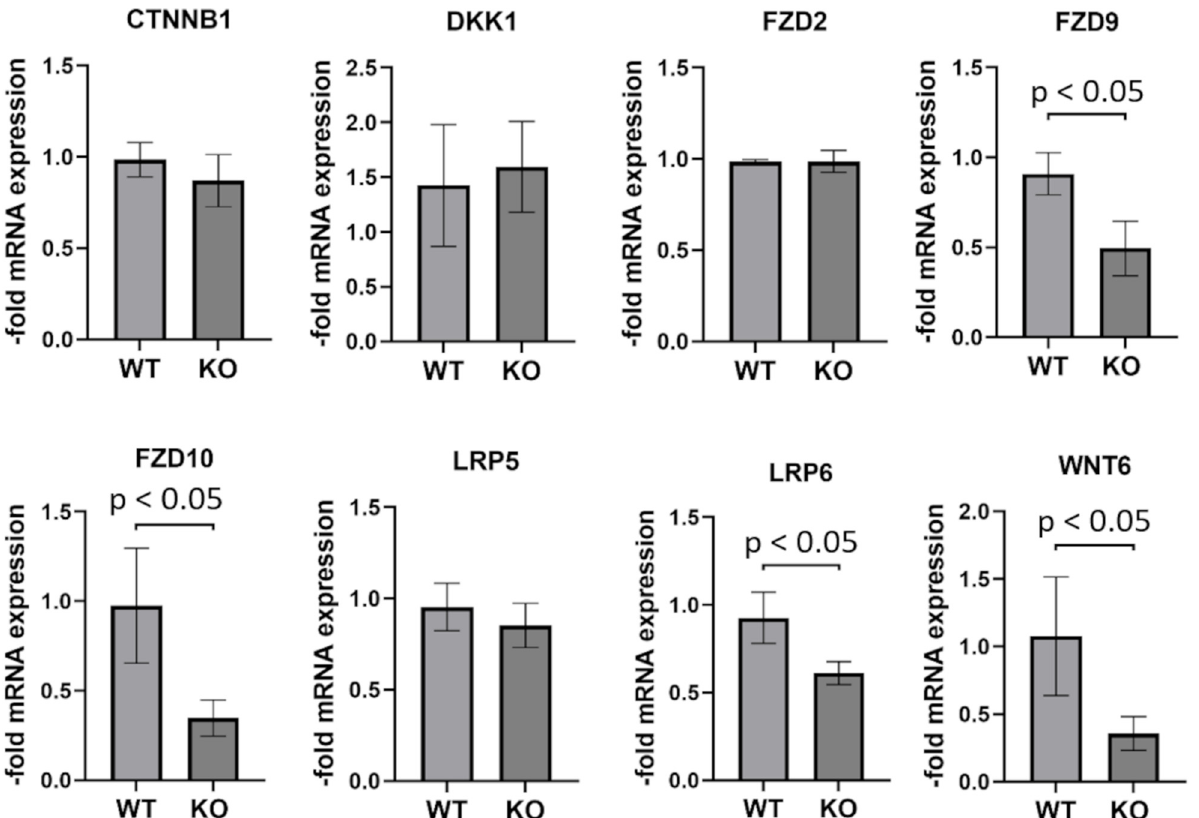
Figure 6. Genes involved in WNT signaling are partially downregulated in U343 PCDHGC3 knockout cells. Different passages of wild type (WT) and PCDHGC3 knockout (KO) U343 cells were used for RNA isolation and mRNA analysis by real-time PCR. Target gene expression was normalized to the endogenous control. Data are presented as mean ± standard deviation of n = 4. Statistical significance is indicated by p < 0.05, as measured by the Mann–Whitney test. CTNNB1: β -Catenin; DKK1: Dickkopf WNT Signaling Pathway Inhibitor; FZD2, 9, 10: Fizzled Class Receptor 2, 9, 10; LRP5, 6: LDL Receptor Related Protein 5, 6; WNT6: WNT Family Member 6.